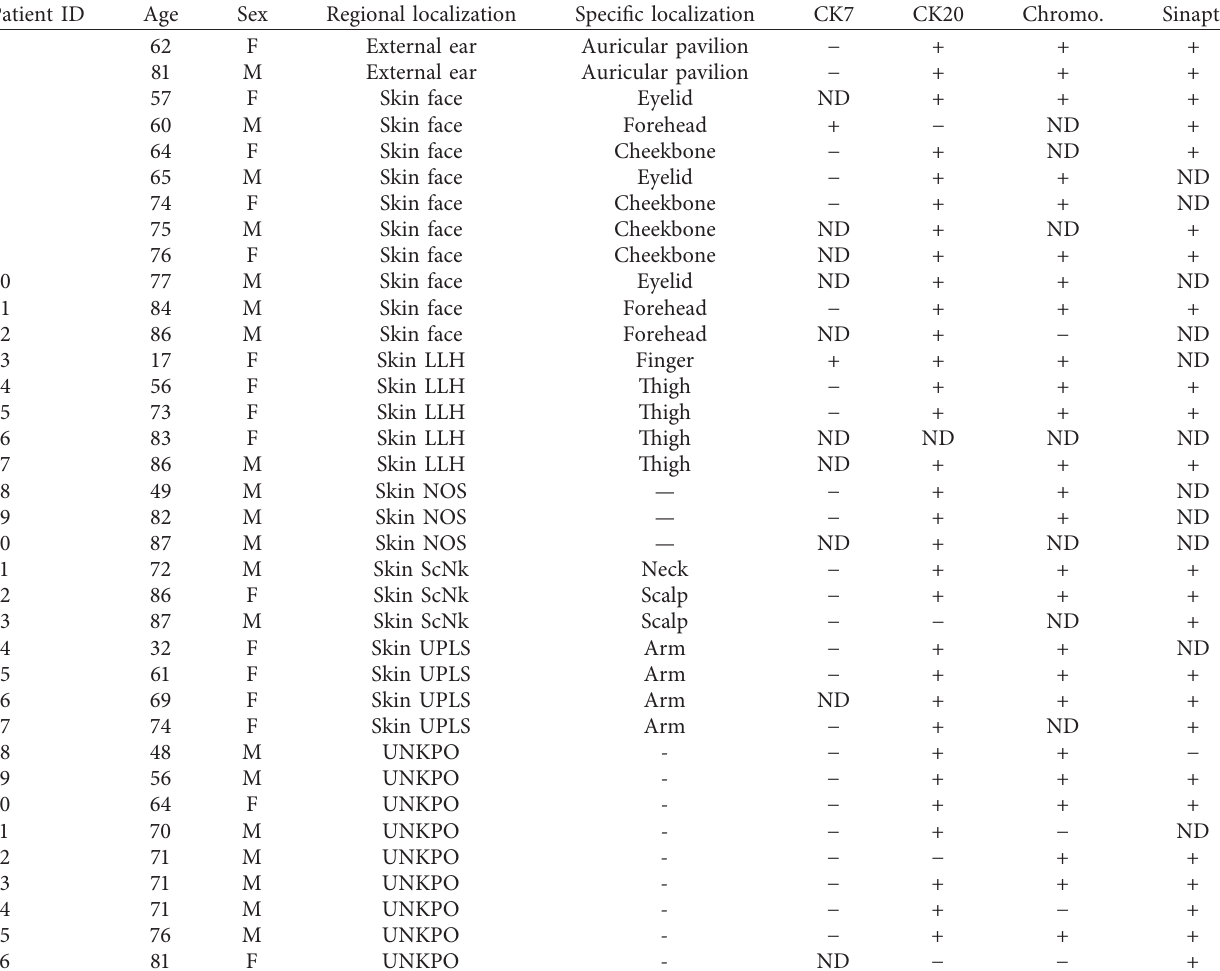
Table 1: Patient